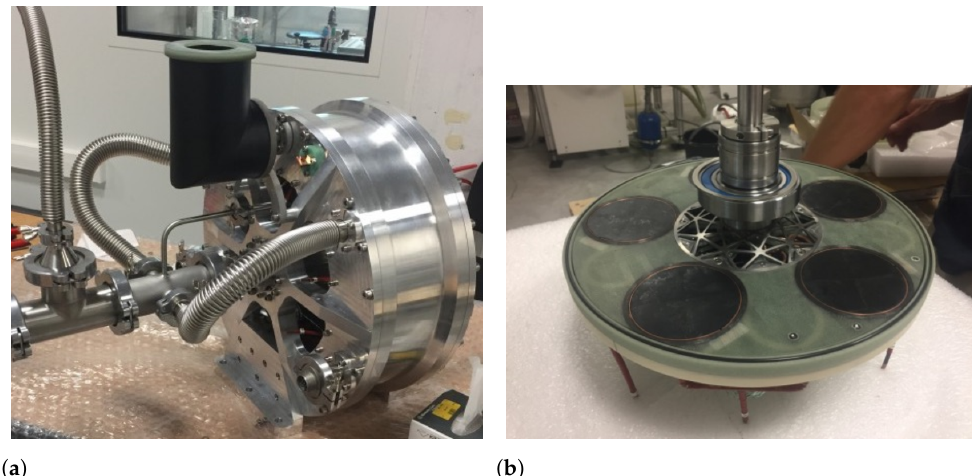
Figure 9. 50 kW superconducting machine prototype from [46], licensed under CC BY 3.0. ( a ) Proto- type withouth cryostat; ( b )